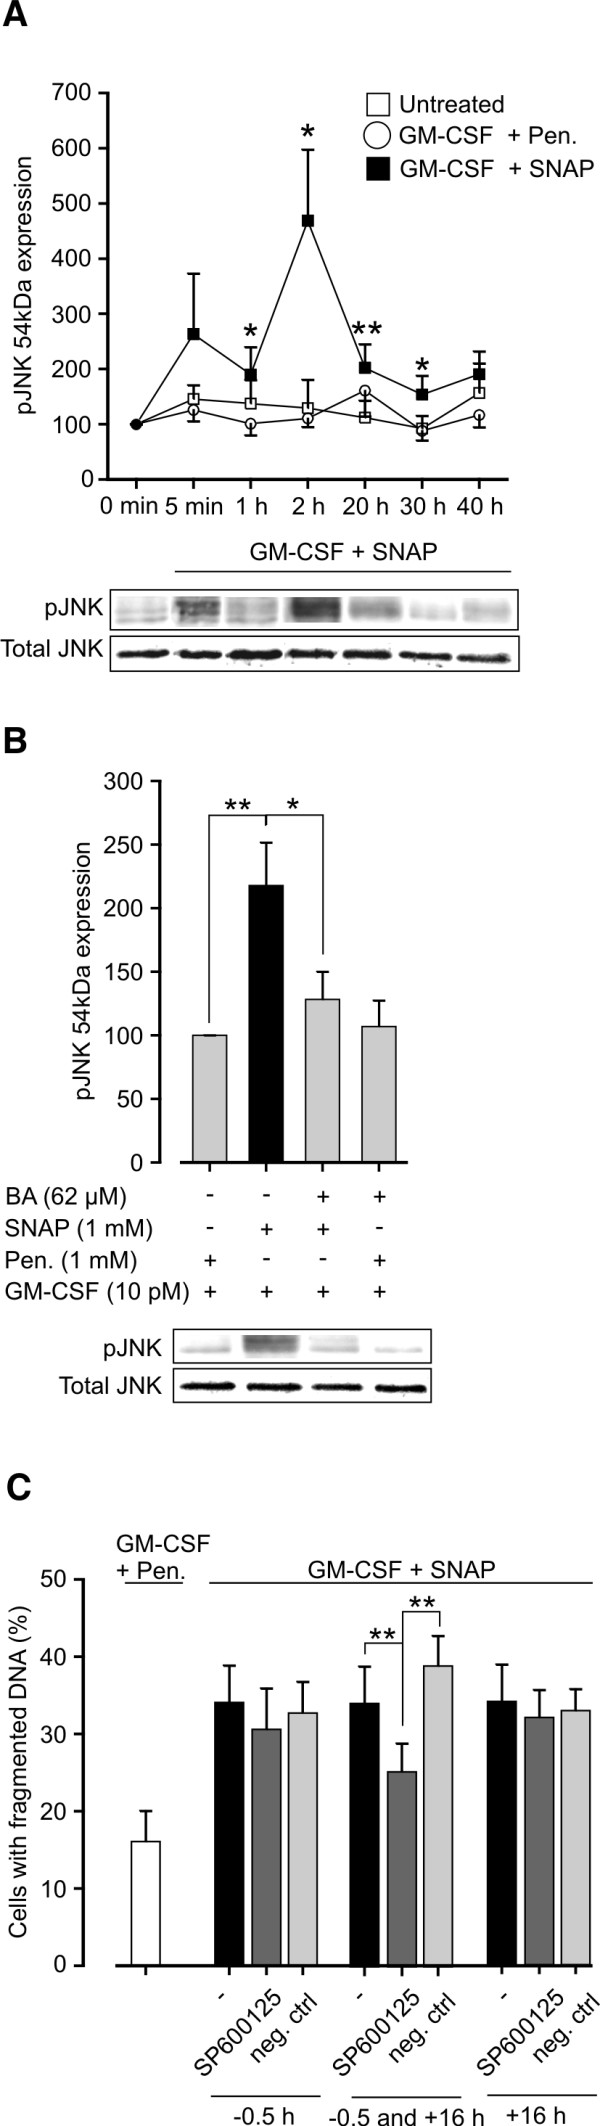
JNK mediates SNAP-induced apoptosis but is also strongly induced by early non-apoptotic mPT. In A eosinophils were incubated in the presence or absence of 1 mM SNAP, 1 mM penicillamine and/or 10 pM GM-CSF for indicated times and lysed for western blotting. pJNK and total JNK levels were normalized against 0 min GM-CSF (10 pM) sample. Total JNK was used as loading control and shown are 54 kDa pJNK and total JNK. * indicates p < 0.05 and ** p < 0.01 as compared with eosinophils stimulated with GM-CSF and penicillamine for the corresponding time, n = 7. Untreated cells were compared to 0 min GM-CSF sample, n = 5. In B, eosinophils were preincubated with bongkrekic acid for 2 h before adding SNAP, penicillamine and/or GM-CSF. Incubation was continued for 2 h before cell lysis and western blotting. Shown are mean ± SEM of 6 individual experiments. In C, time-points shown below the columns refer to the addition times of solvent, SP600125 (10 μM) or its negative control (10 μM). Time zero represents the time of adding GM-CSF (10 pM) and SNAP (1 mM) or penicillamine (1 mM). Total incubation time was 40 h and DNA fragmentation assay was used for determination of apoptosis. Values are mean ± SEM of 5 individual experiments. * indicates p < 0.05 and ** p < 0.01 versus respective control.